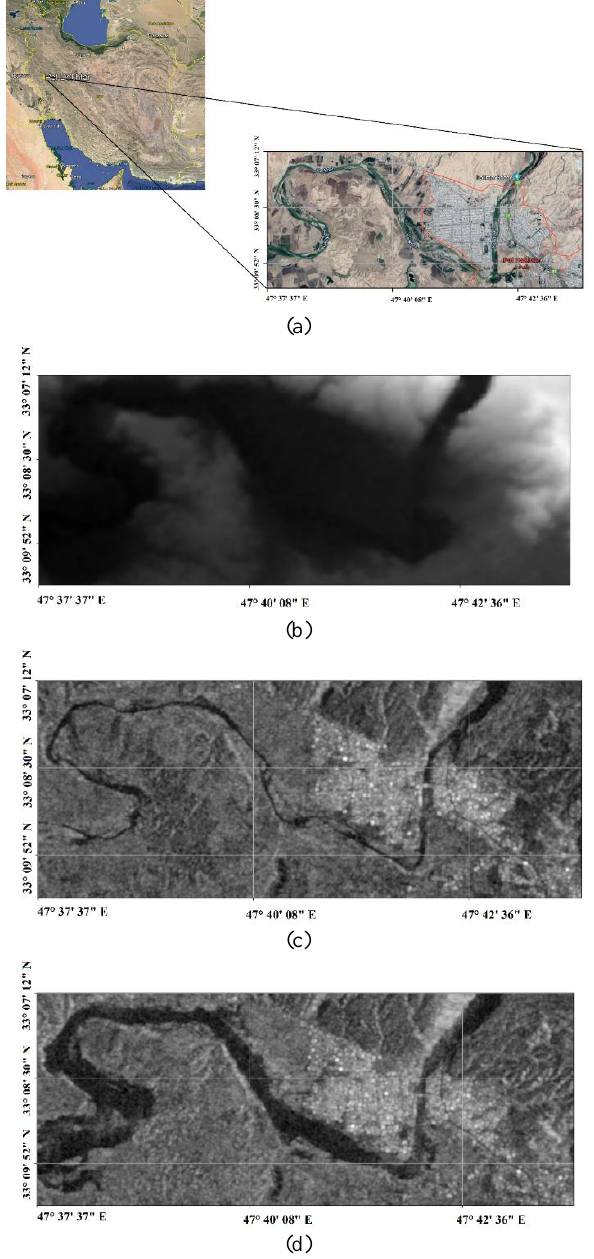
Figure 3. Study area in Poldokhtar, Iran (a) Google Earth view (b) SRTM DEM (c) Sentinel-1-VV, before occurring flood (d) Sentinel-1-VV, after occurring flood